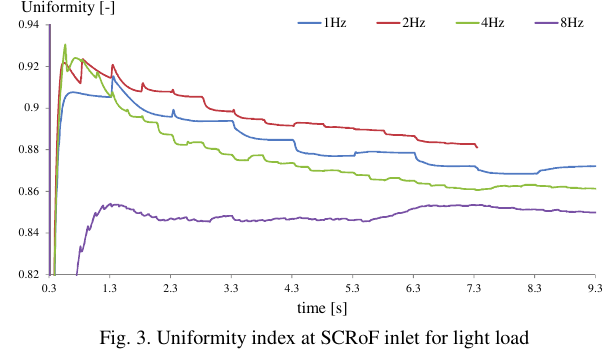
Fig. 3. Uniformity index at SCRoF inlet for light load